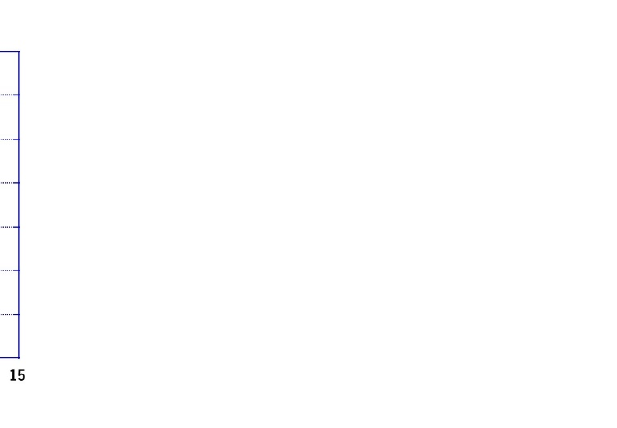
Figure 16. Trap-state density N T estimated from dangling bond density in the sub-boundaries as a function of misfit angle θ .